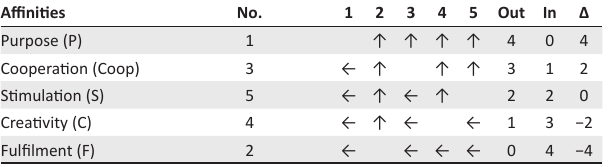
TABLE 2: Interrelationship diagram with affinities in descending order of delta.